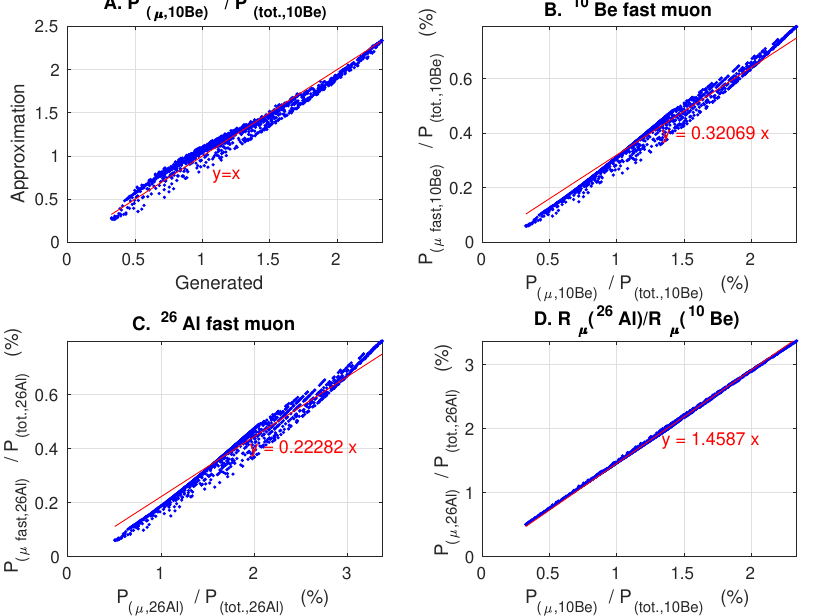
Figure 2. 10 Be and 26 Al surface muon contributions. ( A ) Percentage of 10 Be muon production rates with respect to the total muon production rate generated using P_mu_total_alpha1.m [17] for 1678 land sites, and the approximation calculated using Equation (2) for the same sites. ( B , C ) Share of 10 Be and 26 Al fast muon production with respect to the total muon production at the surface. ( D ) Ratio between the 26 Al and the 10 Be muon